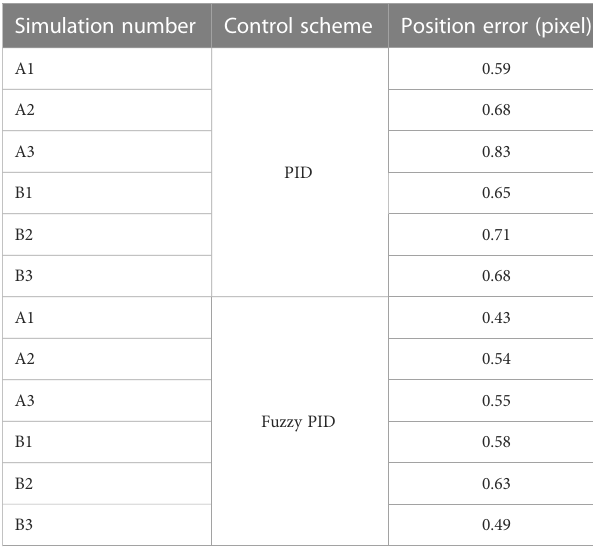
TABLE 1 Mean square of the tracking